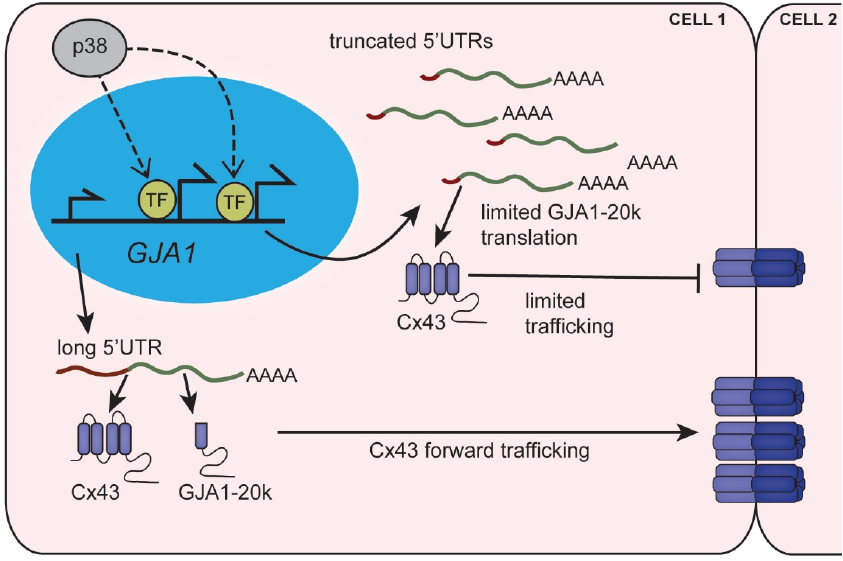
Figure 3. GJA1 -5 (cid:48) UTR truncation regulates alternative translation limiting gap junction formation. Stress signaling in the heart activates p38, which mediates transcription at alternate GJA1 promoters resulting in truncated 5 (cid:48) UTRs. Truncated GJA1 -5 (cid:48) UTRs favor translation of Cx43 over its internal translation product GJA1-20k. Reduced GJA1-20k levels lead to suppression of Cx43 tra ffi cking and limits gap junctions at intercellular